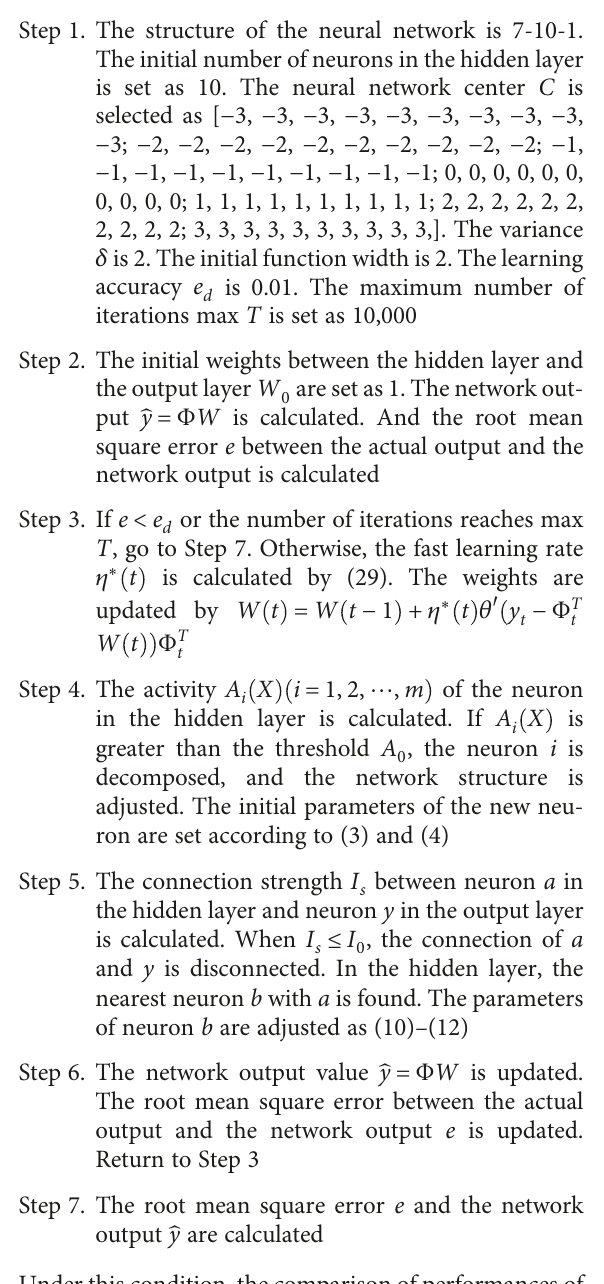
Figure 10: Identi fi cation error of UCI